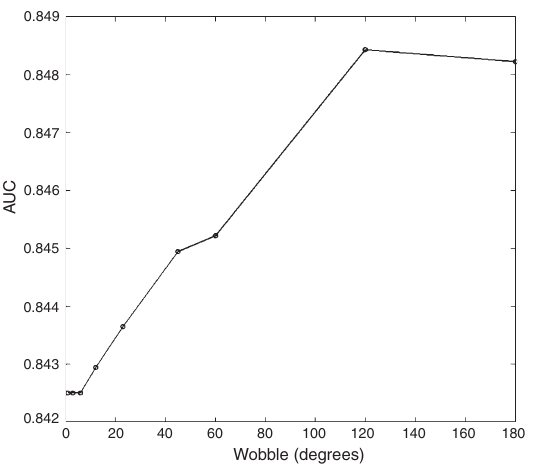
Fig. 6. Effect of wobble. Using a ring vector of 11 pixels in diam- eter with 10 sub-rings, numerous “wobble” angles of 1, 3, 6, 12, 22, 45, 60, 120, and 180 degrees were analyzed. Increasing the angle from 1 to 120 degrees had little improvement on the AUC ( ∼